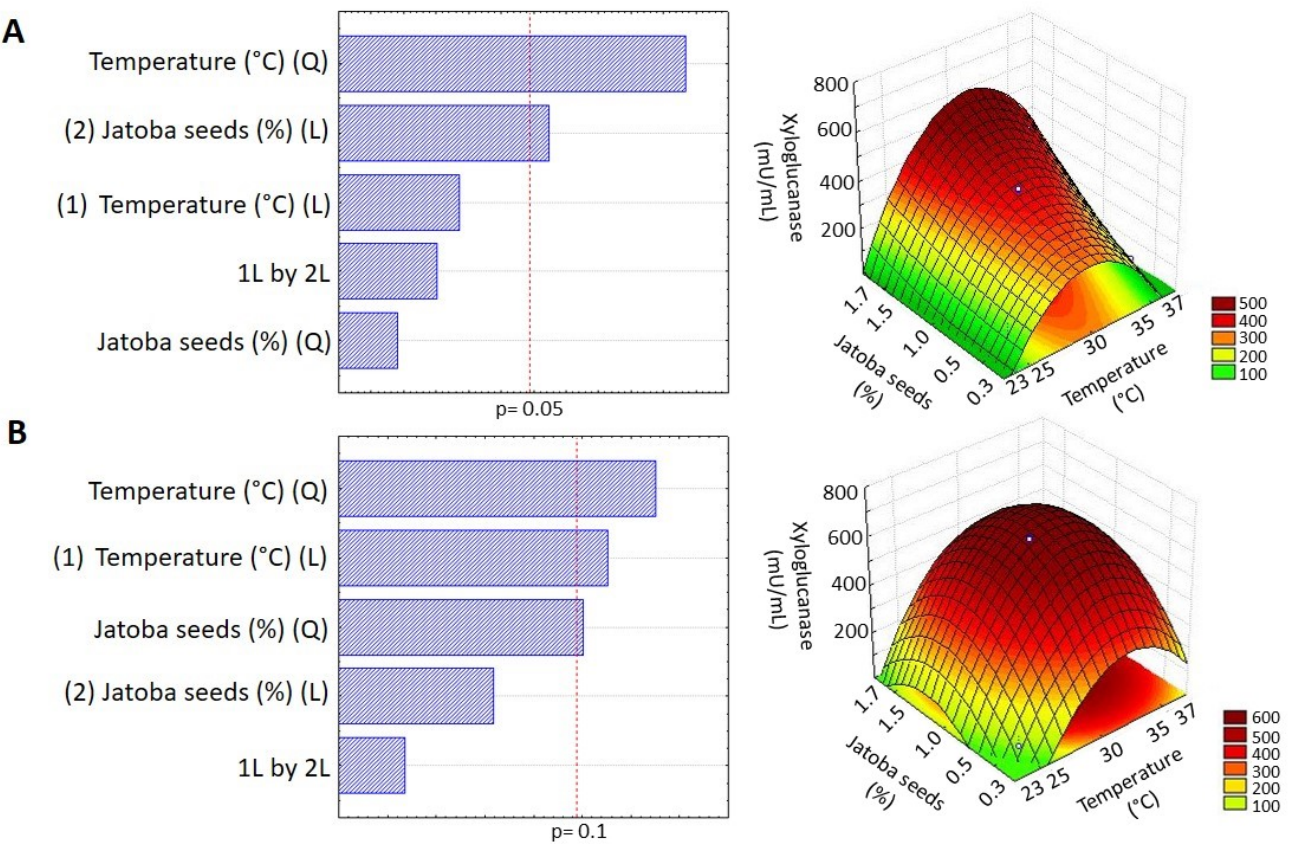
Figure 2. Pareto diagrams and contour graphs detailing the production of T. longibrachiatum xyloglucanase with jatoba seeds after 72 h. ( A )—static cultivation; ( B )—cultivation under agitation.